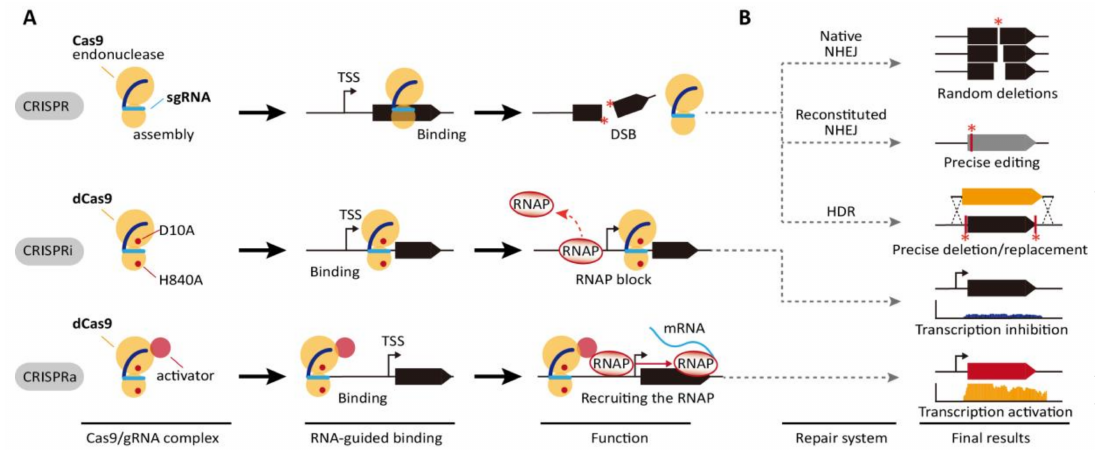
Figure 1. The CRISPR, CRISPRi, and CRISPRa systems. ( A ) CRISPR/Cas system consists of a Cas9 protein and a designed chimeric sgRNA complementary to the genomic target sequence (blue